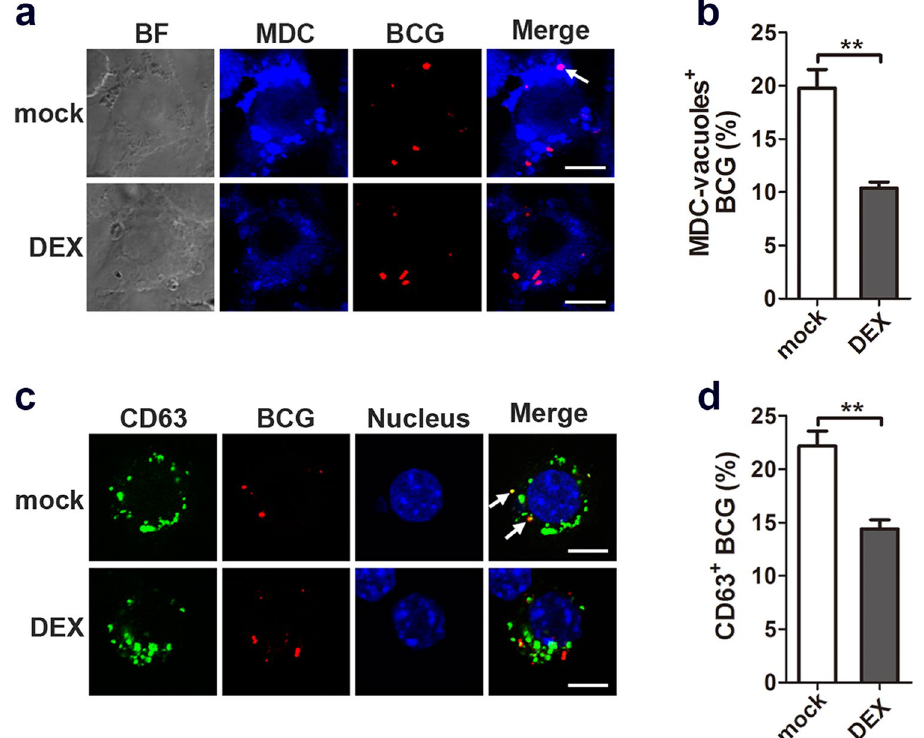
Figure 3. Glucocorticoids inhibit the maturation of BCG phagosomes in macrophages. ( a , b ) RAW264.7 cells were pretreated with dexamethasone (DEX) (1 μ M) or vehicle control ethanol for 24 hr and then challenged with Texas-Red-labeled M. bovis BCG (MOI 10) for 1 hr. Autophagosomes were detected with MDC staining ( a ). The percentage of BCG phagosome colocalizing with MDC-positive vacuoles was calculated in at least 100 phagosomes ( b ). ( c , d ) RAW264.7 cells were treated as described in ( a , b ), and lysosomes were labeled with CD63 (green) ( c ). The percentage of BCG phagosome colocalizing with CD63-positive vacuoles was calculated in at least 100 phagosomes. ( d ). Scale bar, 5 μ m. ** p <